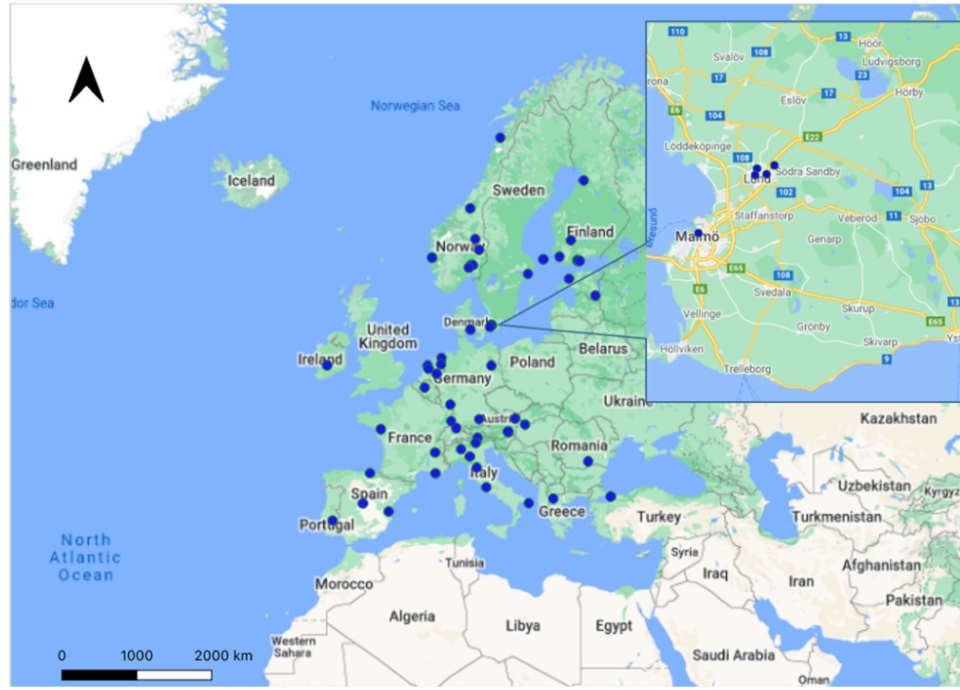
Figure 2. Locations of 60 PED related projects.